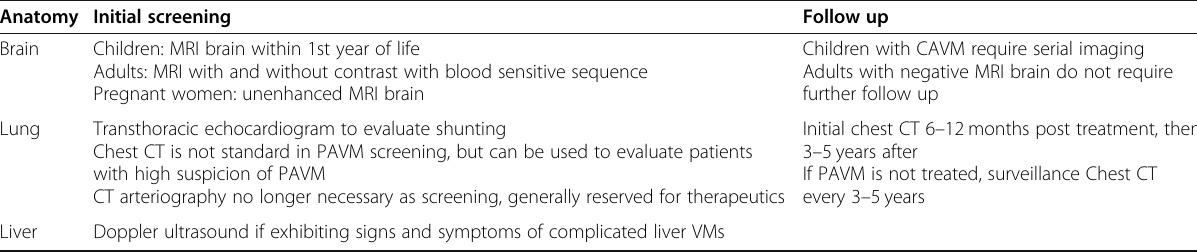
Table 3 Screening Imaging Anatomy Initial